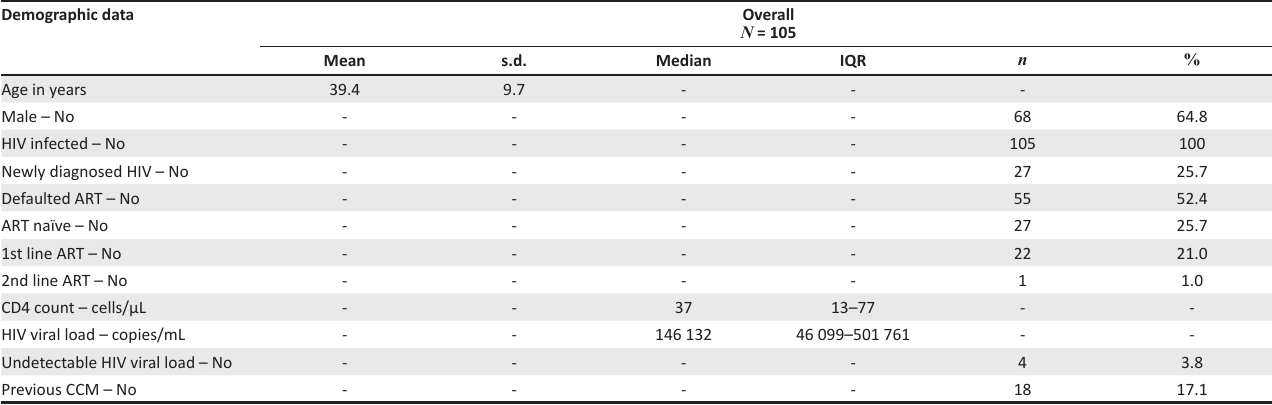
TABLE 1: Baseline characteristics. Demographic data